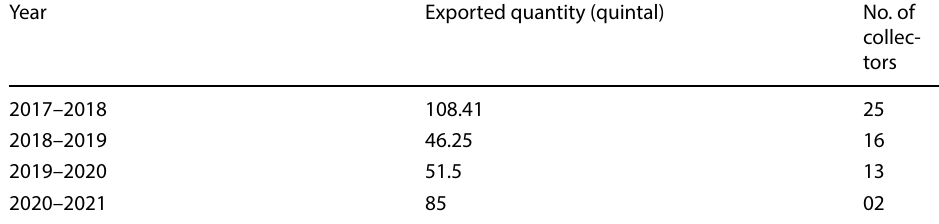
Year Exported quantity (quintal) No. of